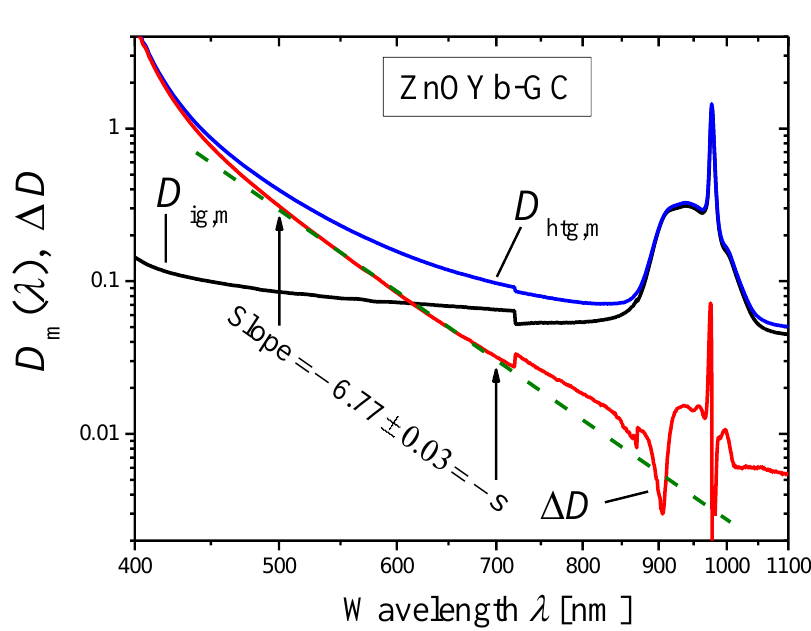
Figure 8. The measured optical densities D ig,m ( λ ) of the sample of the initial glass (with thickness h = 3.00 mm) (black curve) and D htg,m ( λ ) of the sample of the ZnOYb-GC (with thickness h = 3.02 mm) (blue curve), see Equation (7), and their difference ∆ D ( λ ) (red curve) (Equation (8)) (log–log plot). The slope of the linear portion of ∆ D ( λ ) curve was determined by the least squares method in the spectral range shown by arrows, and is indicated in the figure.